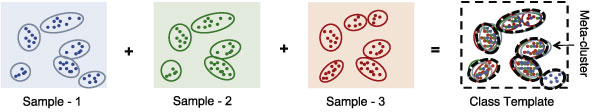
Example. Meta-clusters and a class template: Construction of a class template by merging three samples. Cells are denoted with dots, clusters with solid ellipses and meta-clusters with dashed black ellipses.